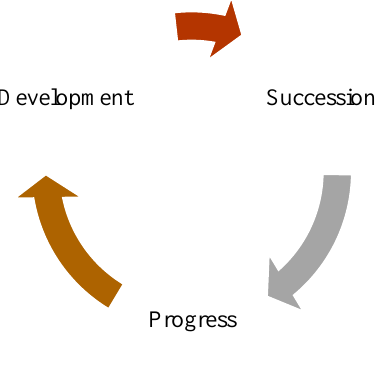
Figure 5. The Framework Proposed by Sobal, Harkins, & Conely